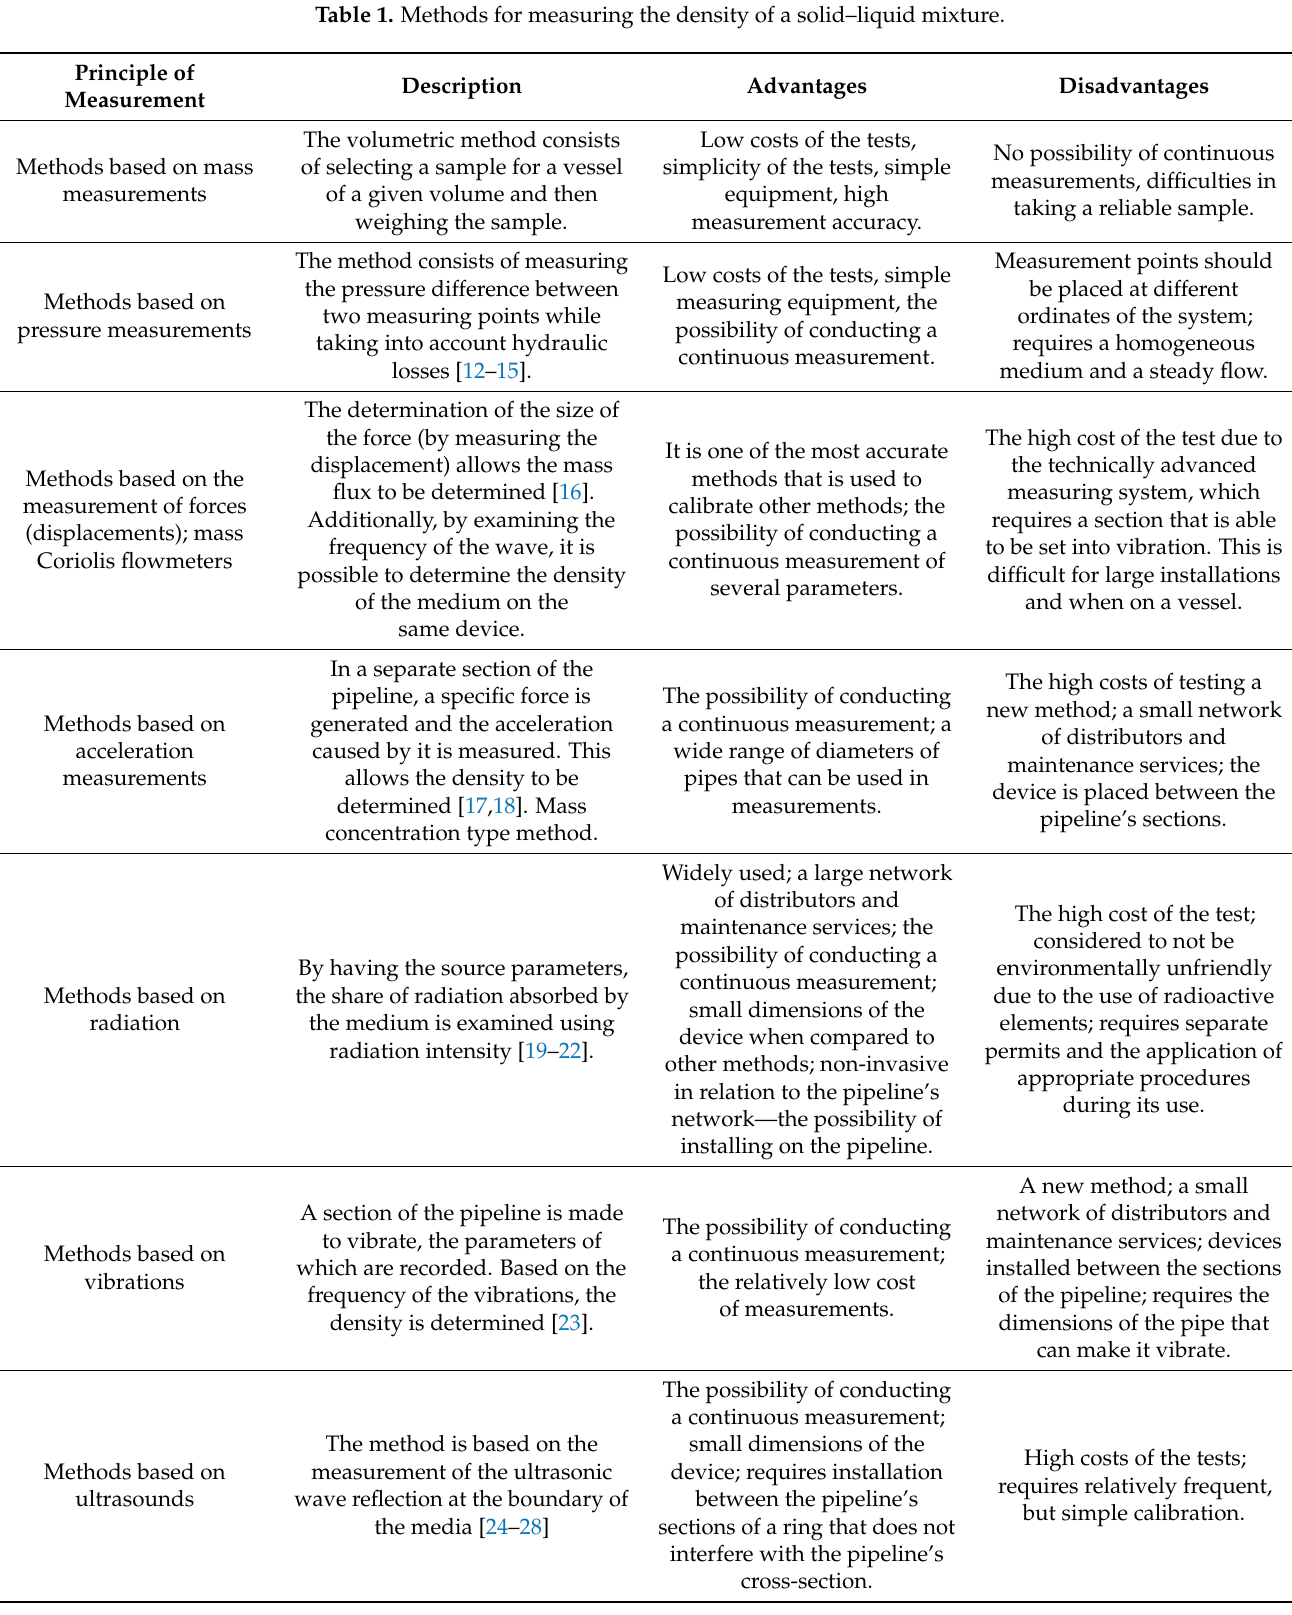
Table 1. Methods for measuring the density of a solid–liquid